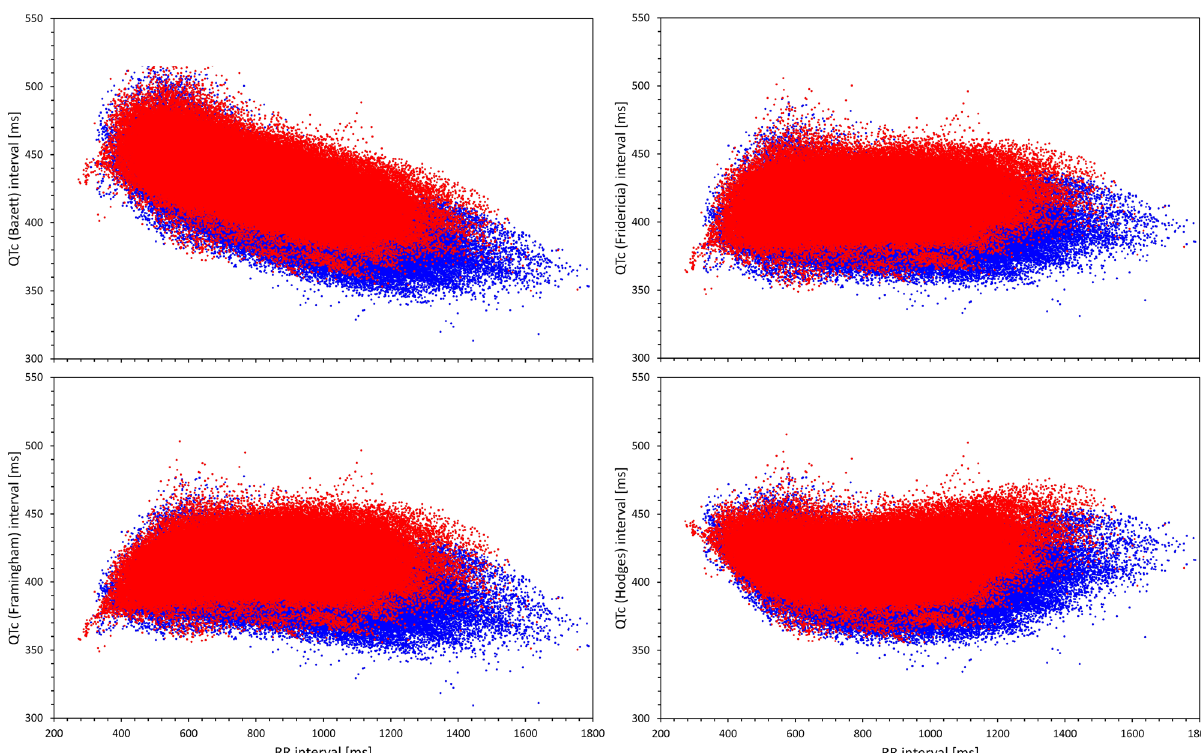
Figure 11. For Bazett (top left panel), Fridericia (top right panel), Framingham (bottom left panel) and Hodges (bottom right panel) correction, the Figure shows scatter diagrams of QTc values versus underlying heart rate (10-s measurement) in all study data pooled together. The data in females (in red) are shown superimposed on top of the data in males (in